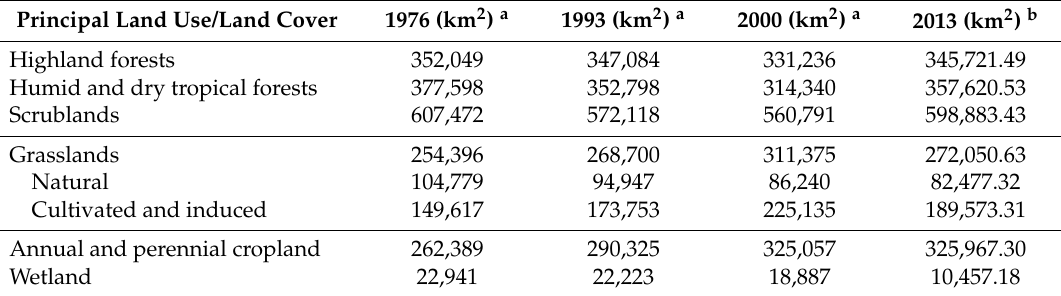
Figure 1. Distribution of cultivated and induced pastureland in Mexico (Data source: INEGI 2013). Black patches represent pastureland cover. The expansion of livestock production is high in southeast of Mexico. Table 1. Historical change in forest and grassland cover (square kilometers) in Mexico.